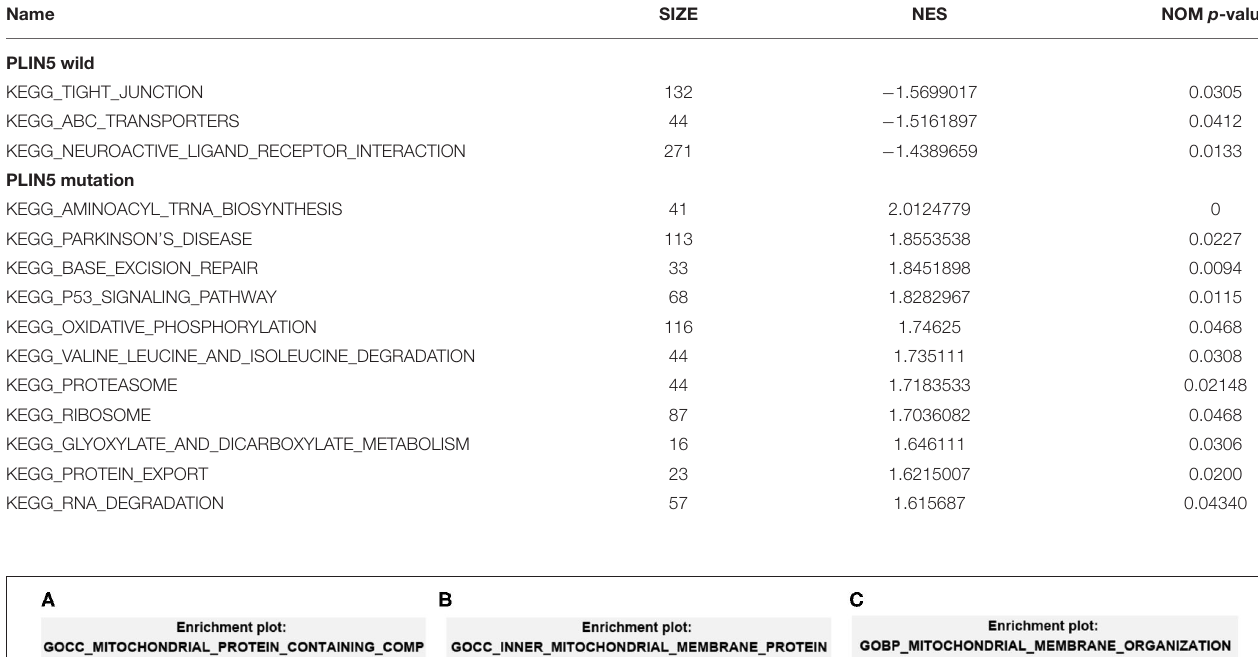
TABLE 3 | GSEA-enriched KEGG pathways in PLIN5 wild and PLIN5 mutation.